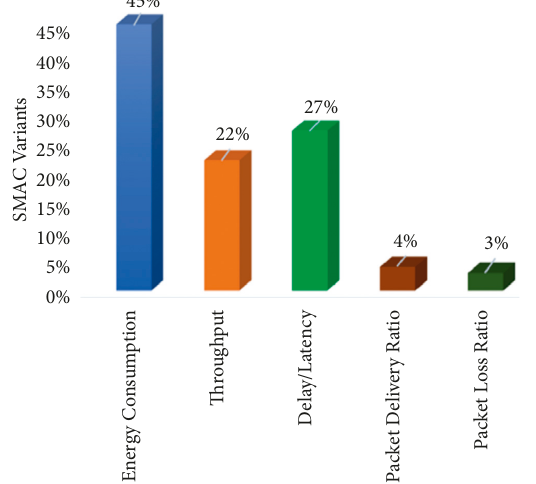
Figure 12: Implementation of SMAC in WSN applications.